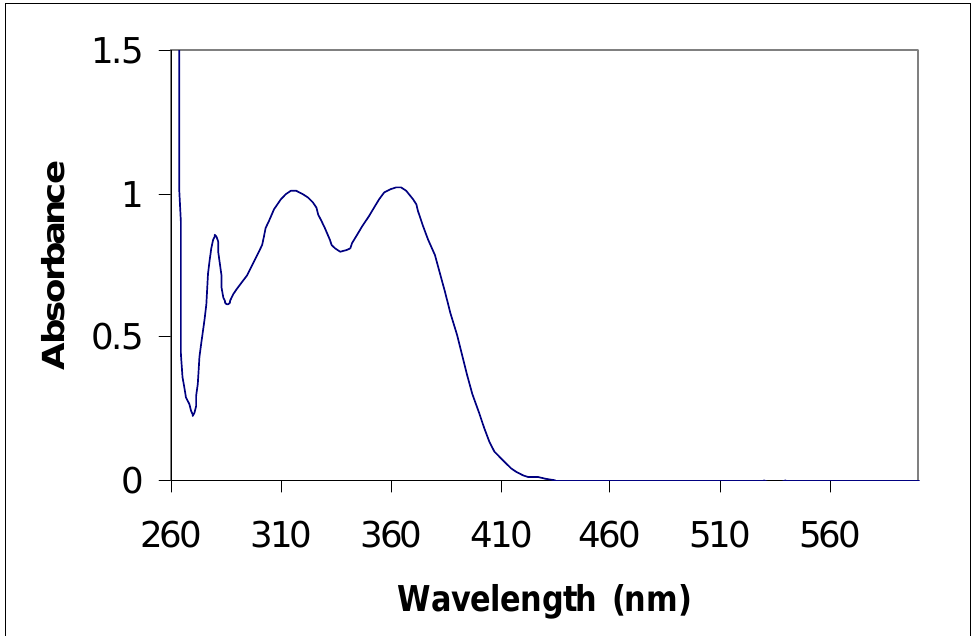
Figure 2. UV-Visible spectra of compound 5b in